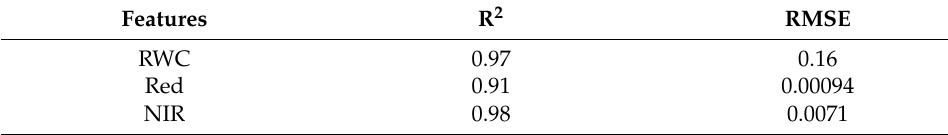
Table 8. The fitted results of other plant phenotyping